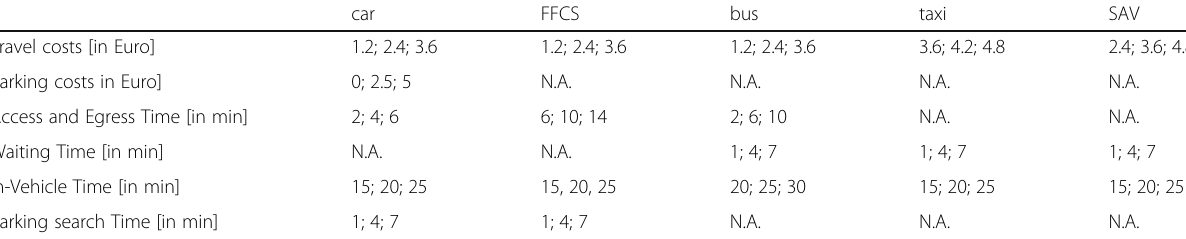
Table 1 Mode attributes and attribute levels presented in the choice experiment. N.A. stands for ‘ not applicable ’